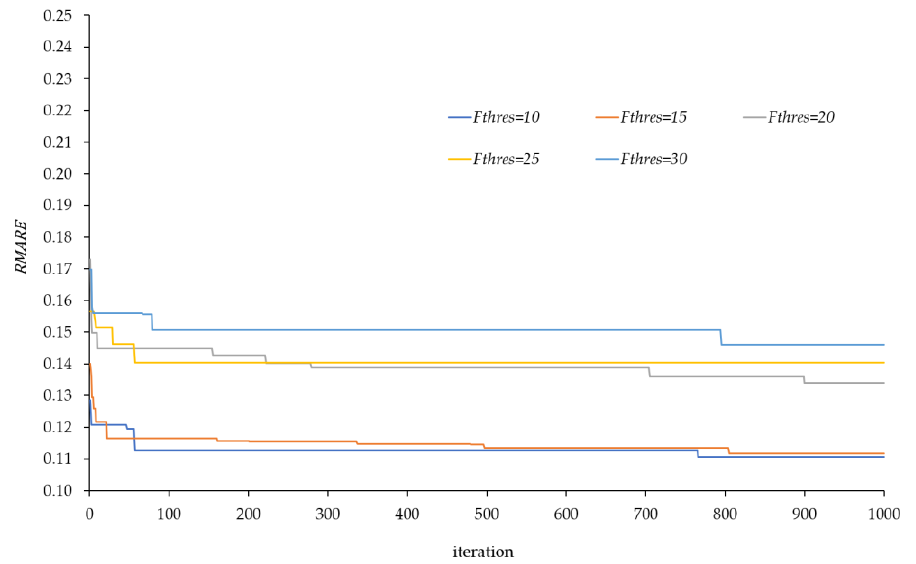
Figure 15. Evolution of 𝑅𝑀𝐴𝑅𝐸 value for the different cases varying the threshold flow.